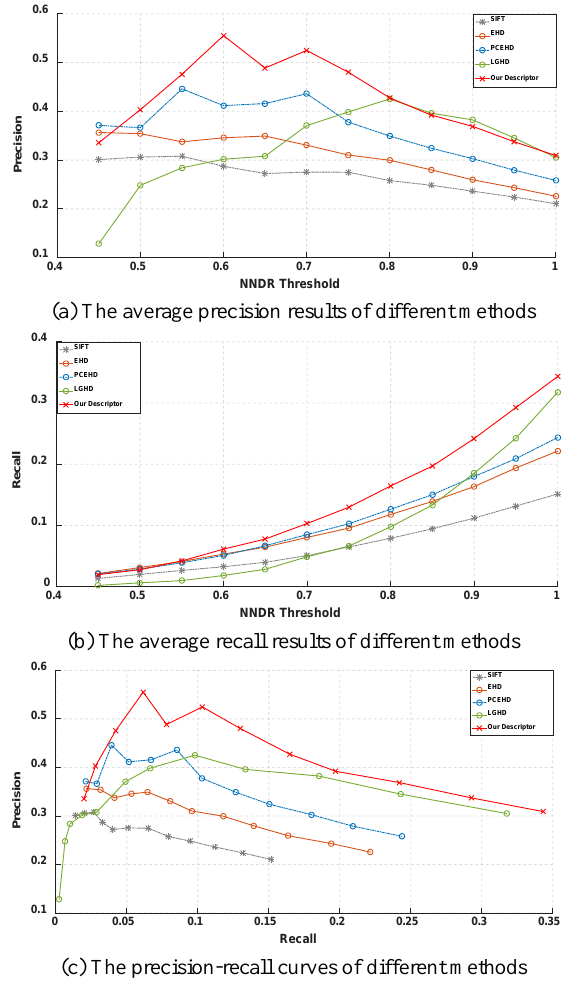
Figure 2. One pair of visible (left) and TIR (right) images